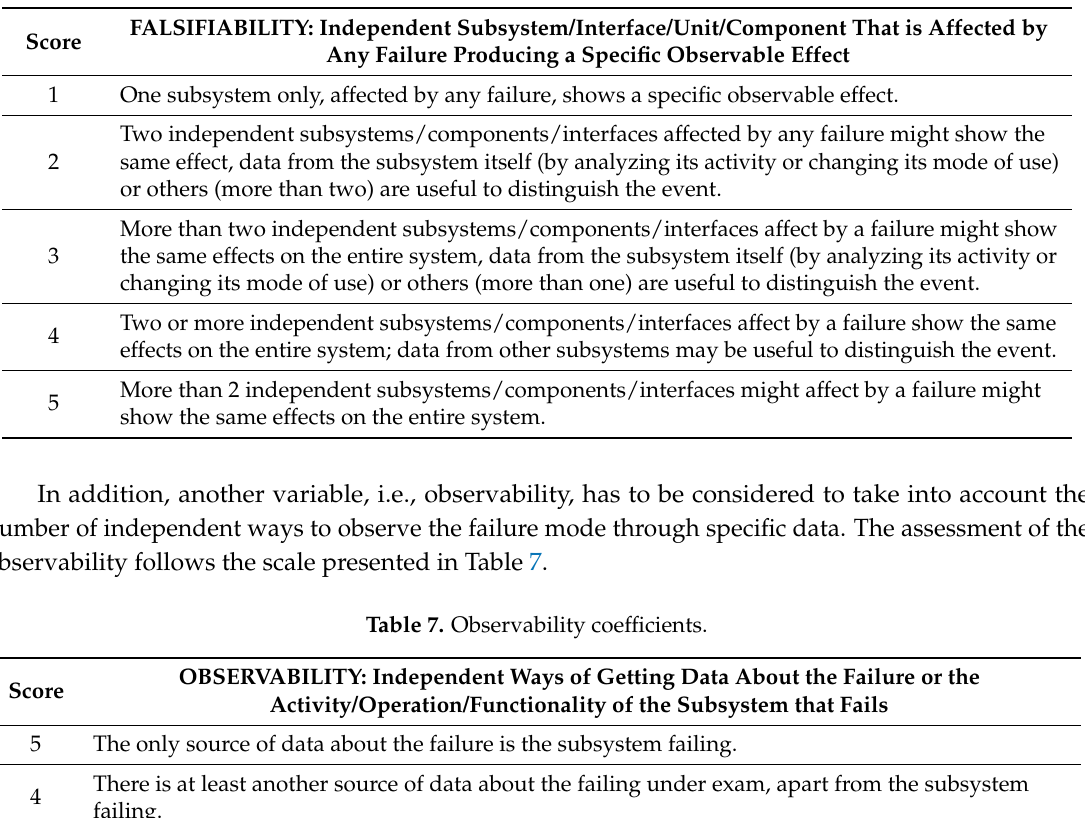
Table 6. Falsifiability coefficients.